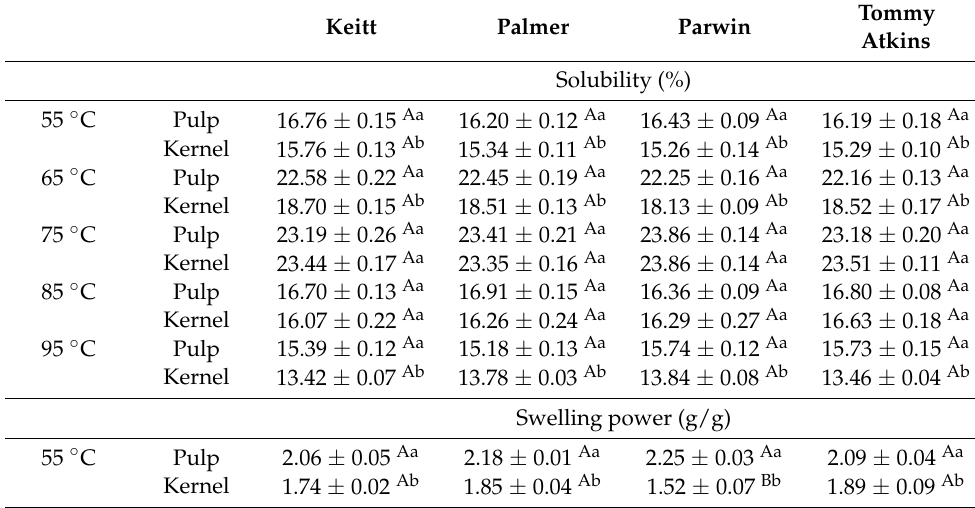
Table 3. Solubility and swelling power of mango starches.